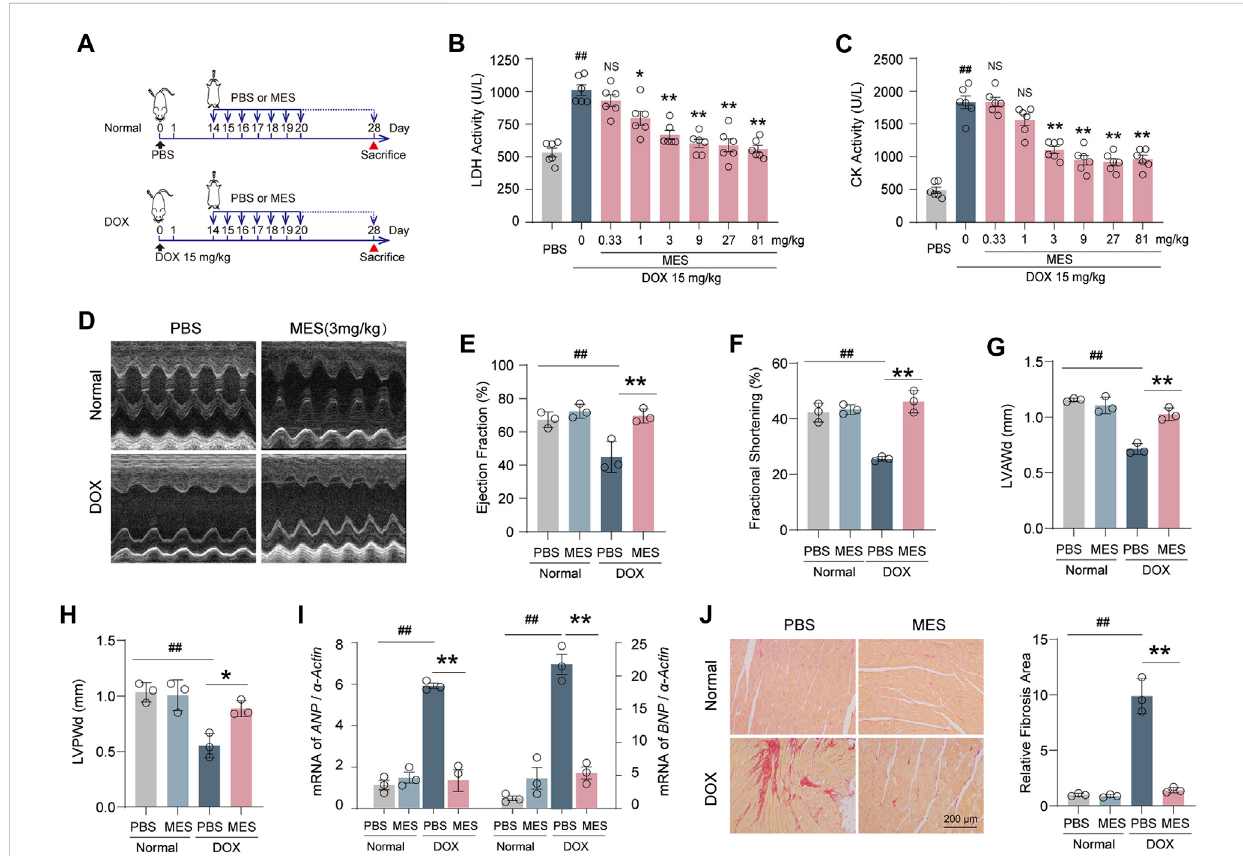
FIGURE 2 Mesaconine protected mice from acute DIC by reducing cardiac dysfunction and remodeling. (A) Flowchart for preparing acute DIC model and corresponding treatments. (B, C) The dose-dependent serum activity of LDH and CK. (D) Representative images of left ventricular M-mode echocardiograms (n = 6 – 8/group). Left ventricular ejection fraction [EF, (E) ], fractional shortening [FS, (F) ], and diastolic anterior wall thickness [LVAWd, (G) ], posterior wall thickness [LVPWd, (H) ] were measured by echocardiography. (I) RT-PCR detected mRNA expression of ANP and BNP . (J) Representative images of Sirius red stained heart sections and a summary of collagen deposition. Data are represented as means ± SEM of at least 3 biologically independent replicates assays. * p < 0.05; **, ## p <